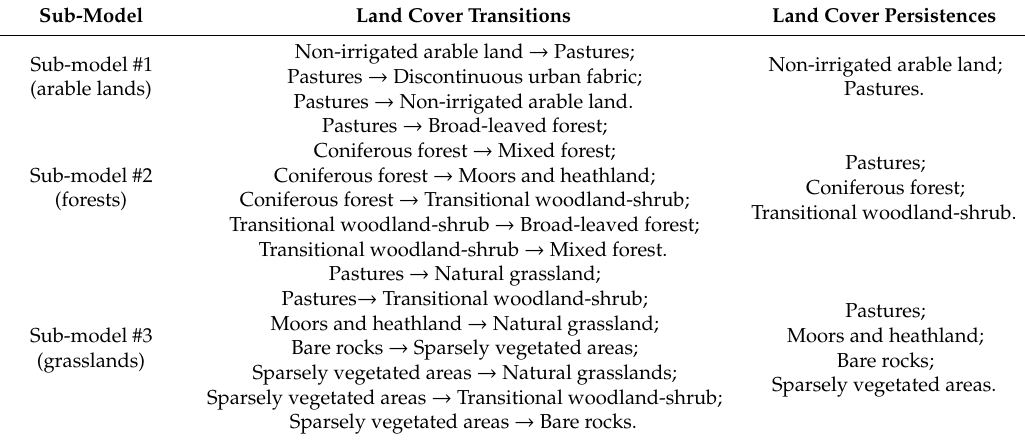
Table 1. Main land cover transitions and land cover persistences highlighted by the change detection analysis for the period 2000–2015.